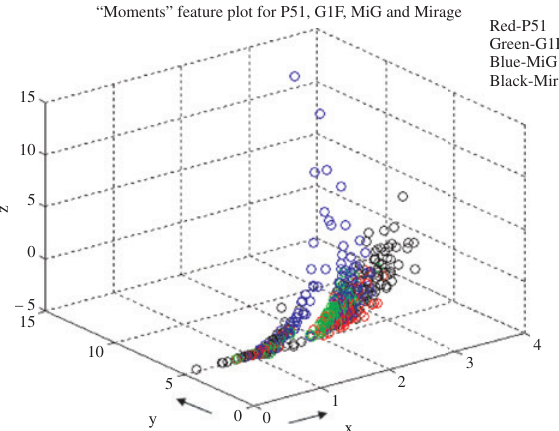
Figure 6: Plot of FS2 for the P51, G1F, MiG and Mirage Aircraft Models.